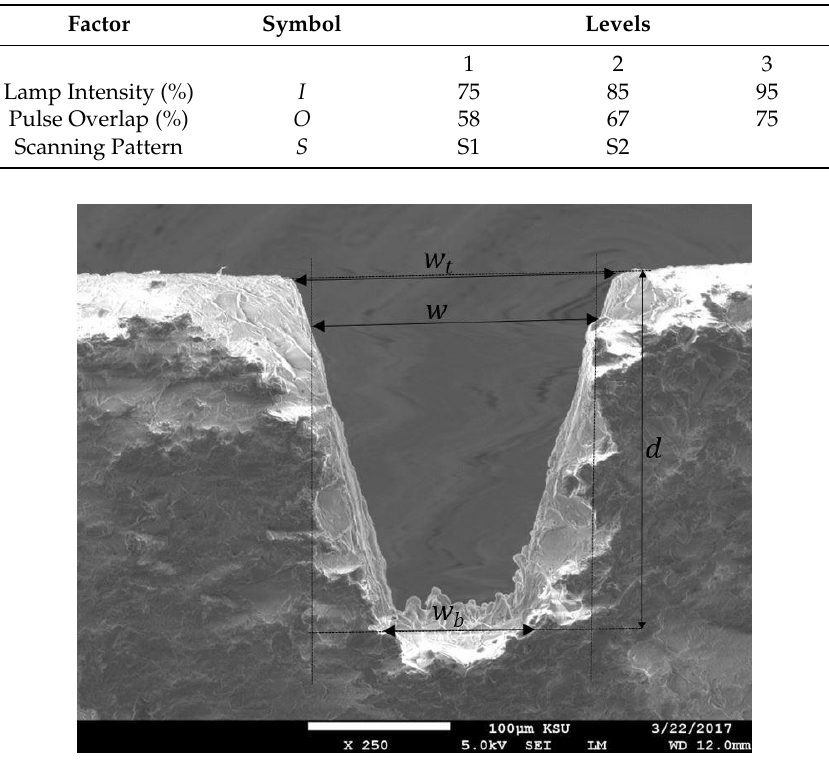
Figure 4. Illustration of channel’s dimensional characteristics: Top width ( w t ), bottom width ( w b ) and total depth ( d ). Grey Relational Grade Method